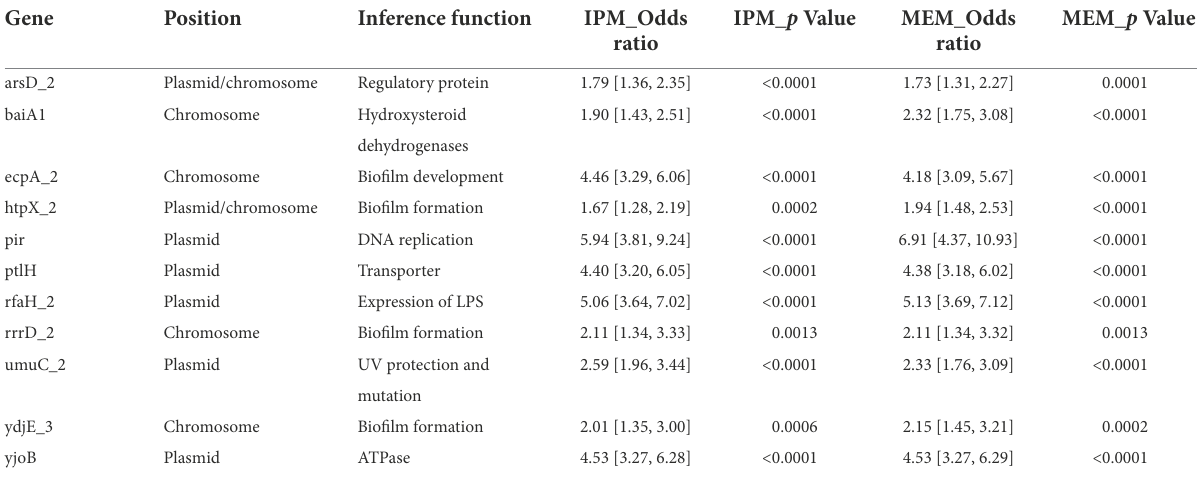
TABLE 4 Genes and their functions identified in the validation